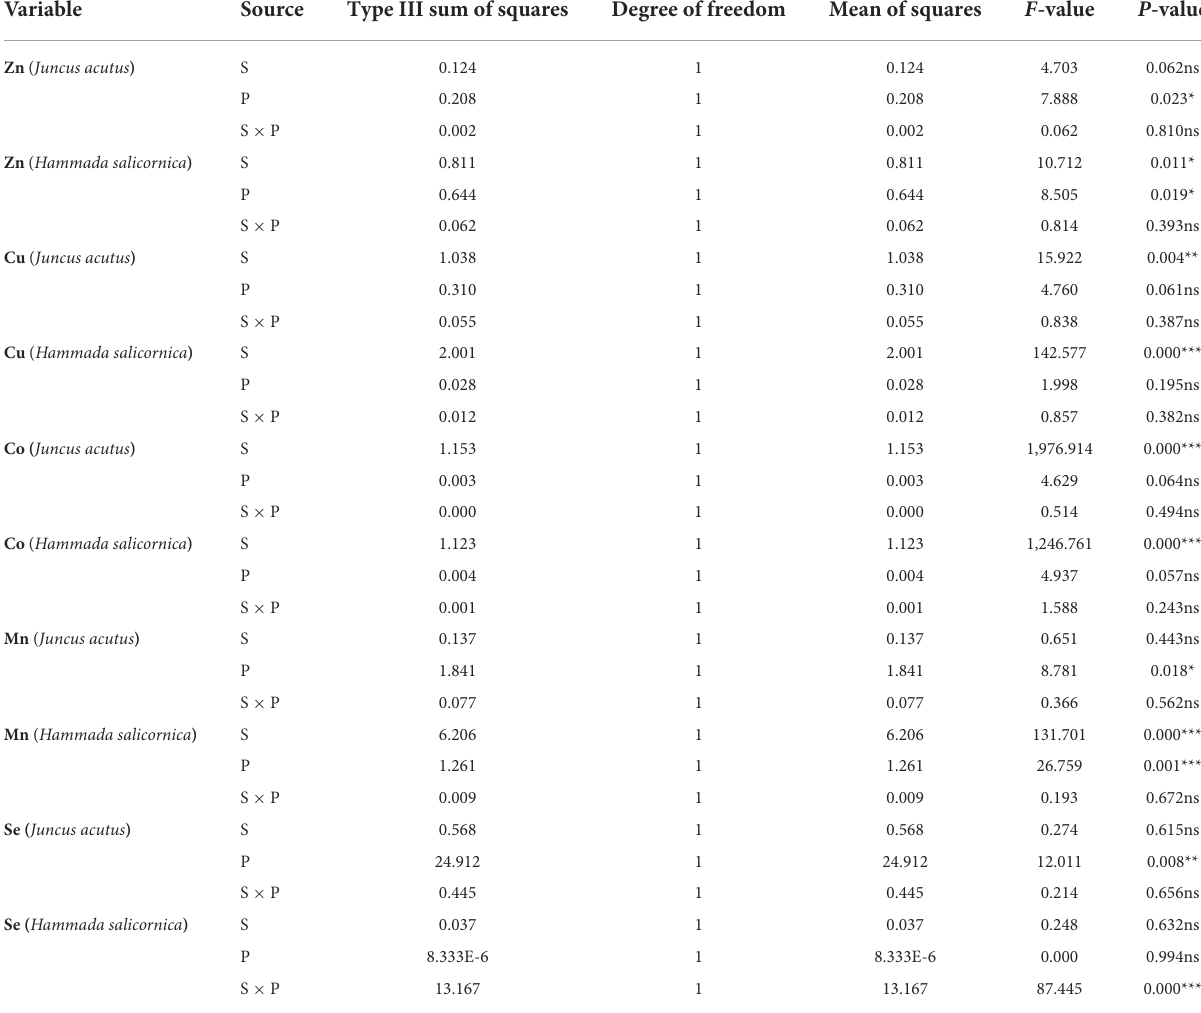
TABLE 3 Analysis of variance (ANOVA) for metal concentrations in coastal plant materials of the Shadegan wetland. Variable Source Type III sum of squares Degree of freedom Mean of squares F -value P